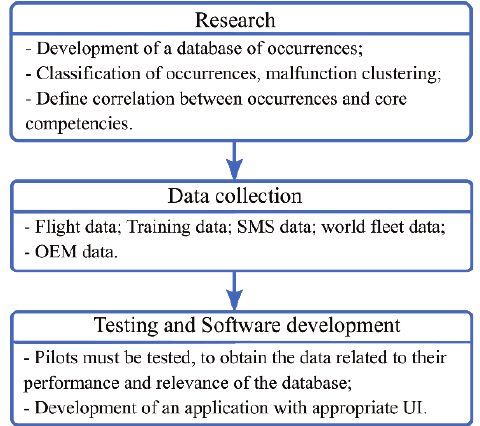
Figure 5. Further development